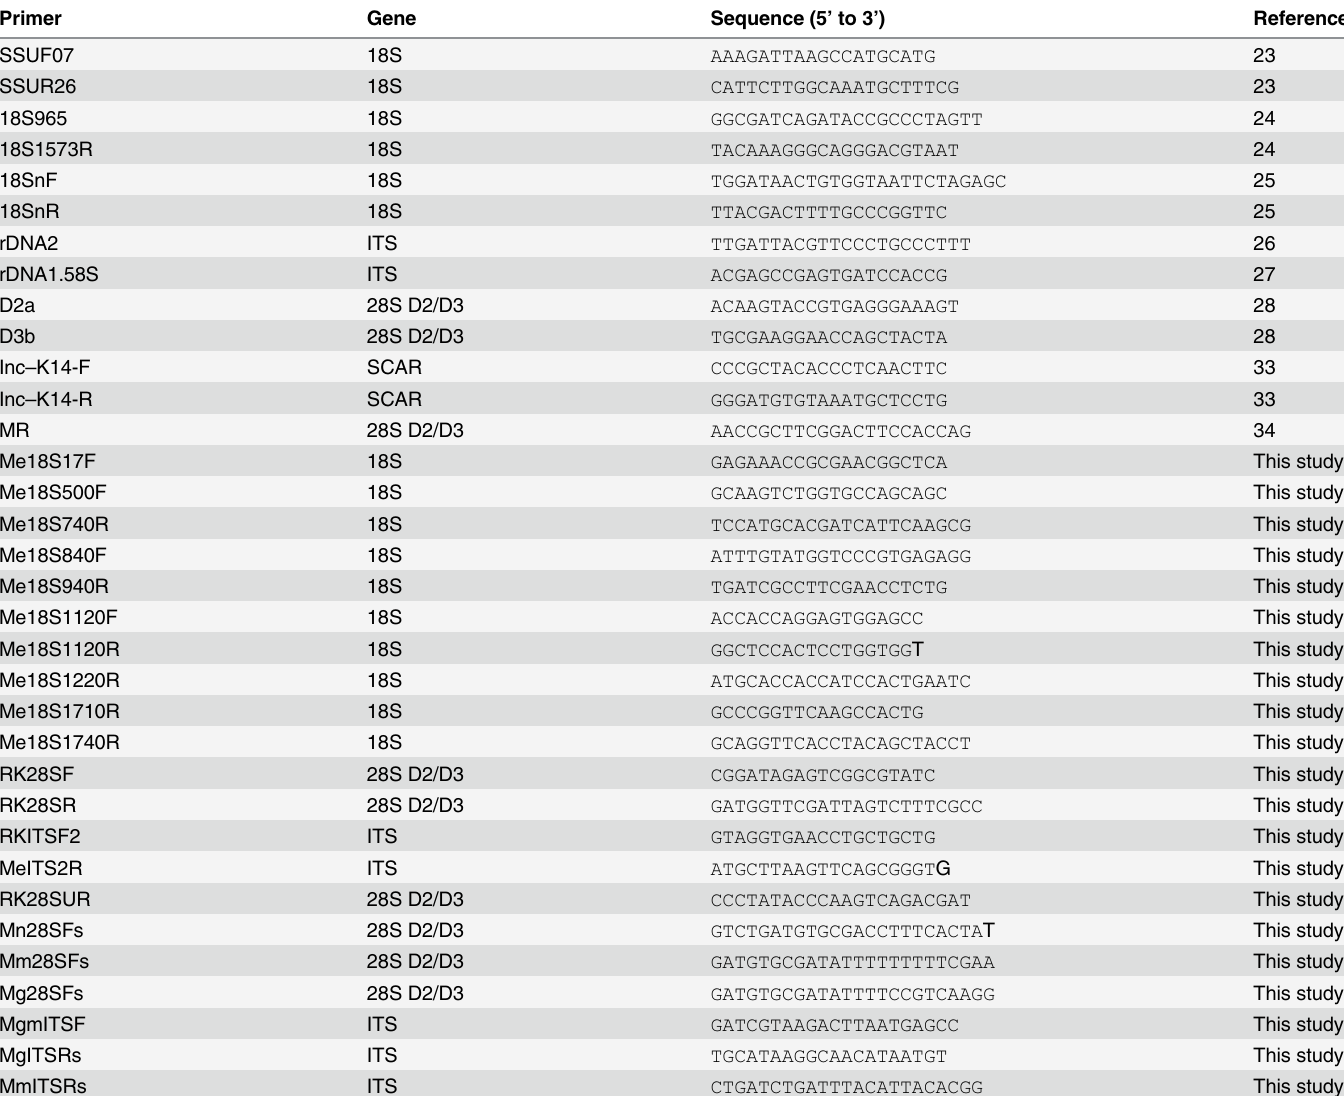
Table 2. Primers used for polymerase chain reaction and DNA